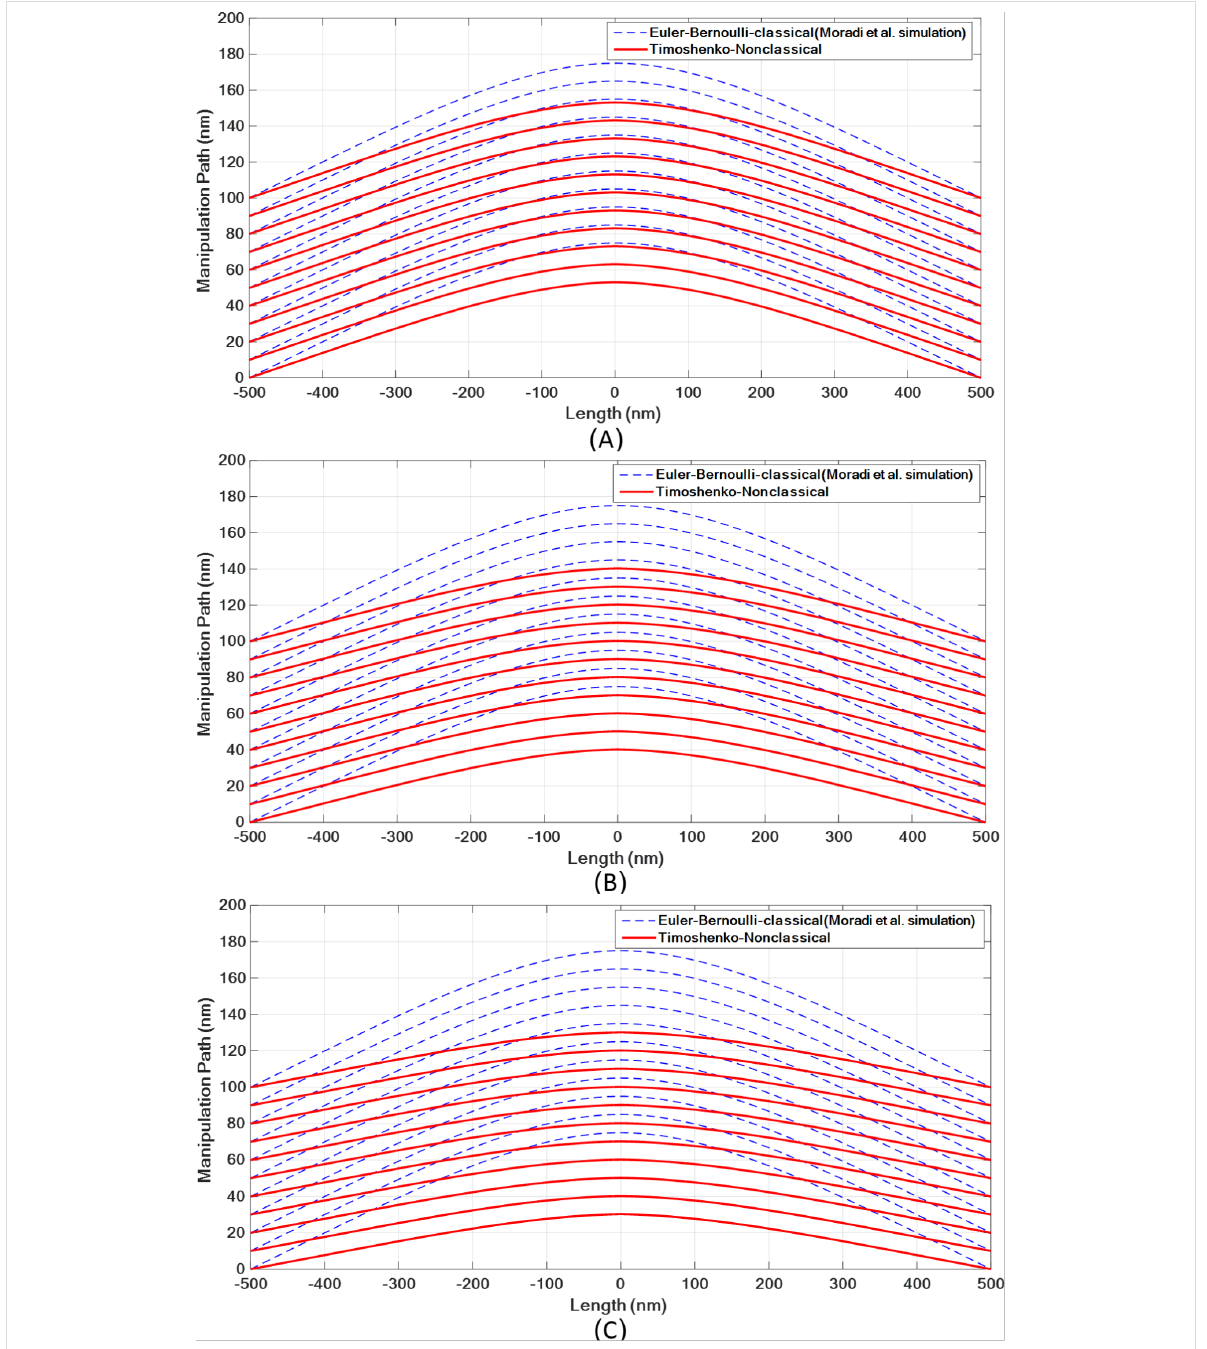
Figure 22: Simulation of the manipulation process of a polystyrene nanorod and comparison with the presented model by Moradi et al. [8]. A: l / d = 2/8. B: l / d = 3/8. C: l / d = 4/8.